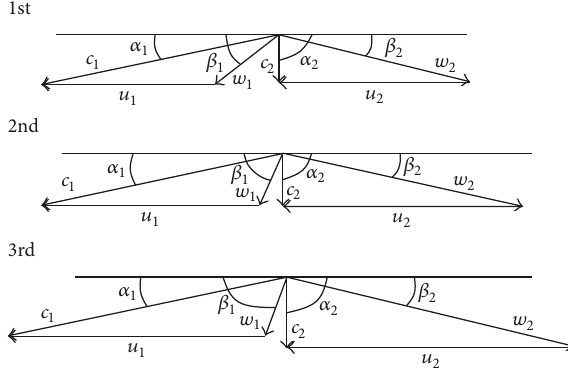
Figure 3: The speed triangle of the centrifugal